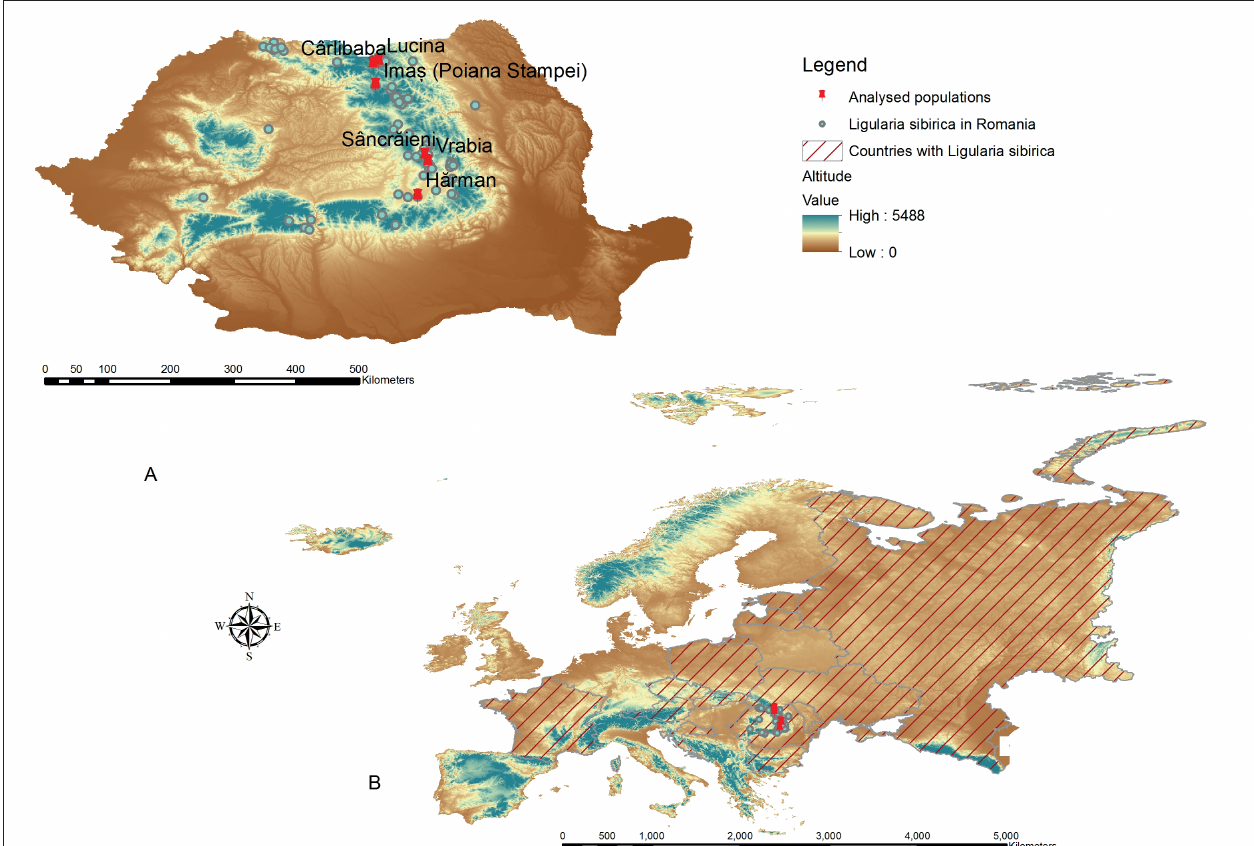
Figure 1 – A, distribution of Ligularia sibirica in Romania and the analysed populations; B, the European countries where Ligularia sibirica is present. Adapted after Bernhardt et al.